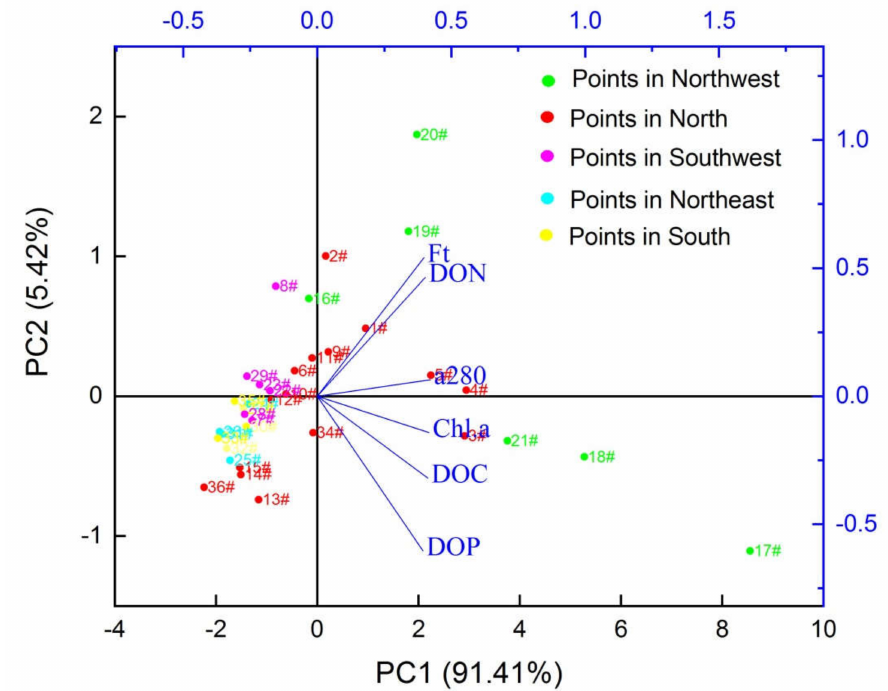
Figure 6. Plots of samples and variables from a principle components analysis of DOC, a 280 , F t , chl. a , DON, and DOP in the overlying water of Lake